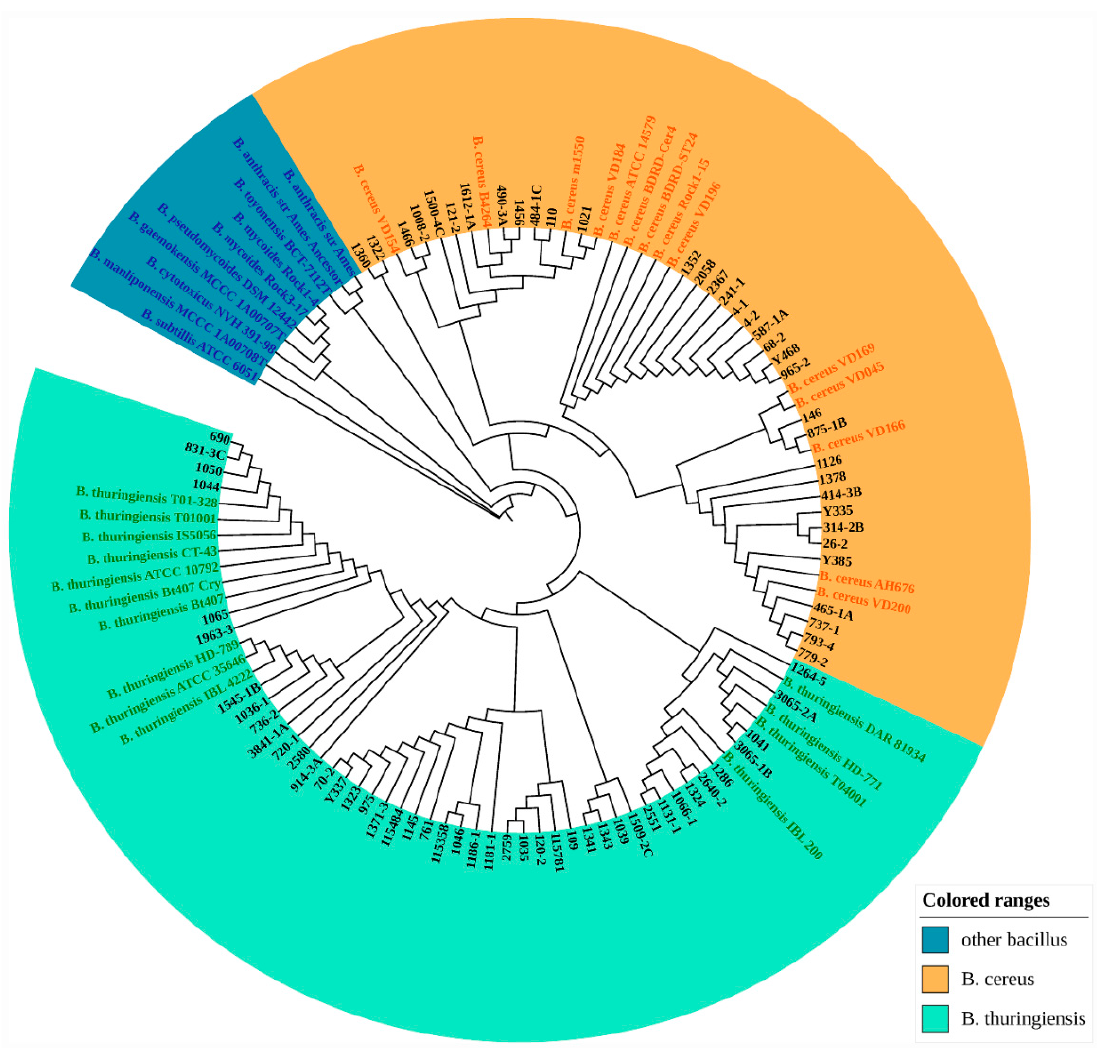
Figure 1. pycA gene-based phylogenetic tree of Bacillus cereus , Bacillus thuringiensis , and other Bacillus cereus group species. Branch quality was evaluated using 1000 bootstrap replicates. The reference strains are indicated in color, and the isolated strains are indicated in black.